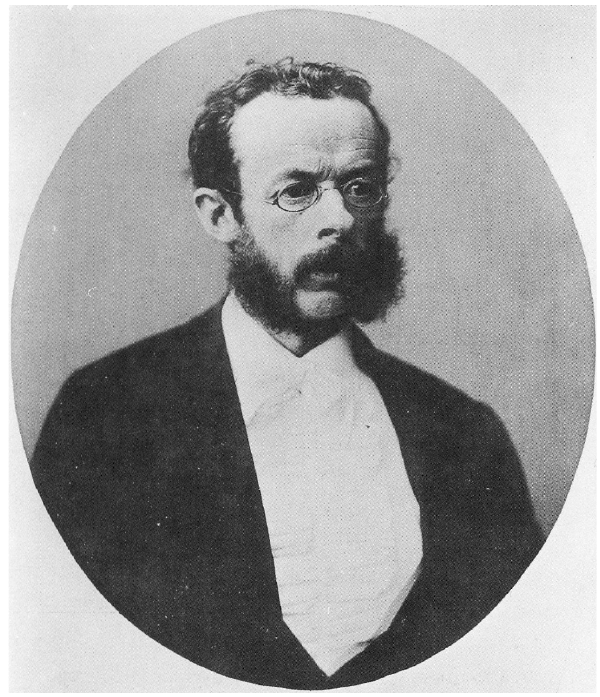
Figure 7. Sophus Tromholt